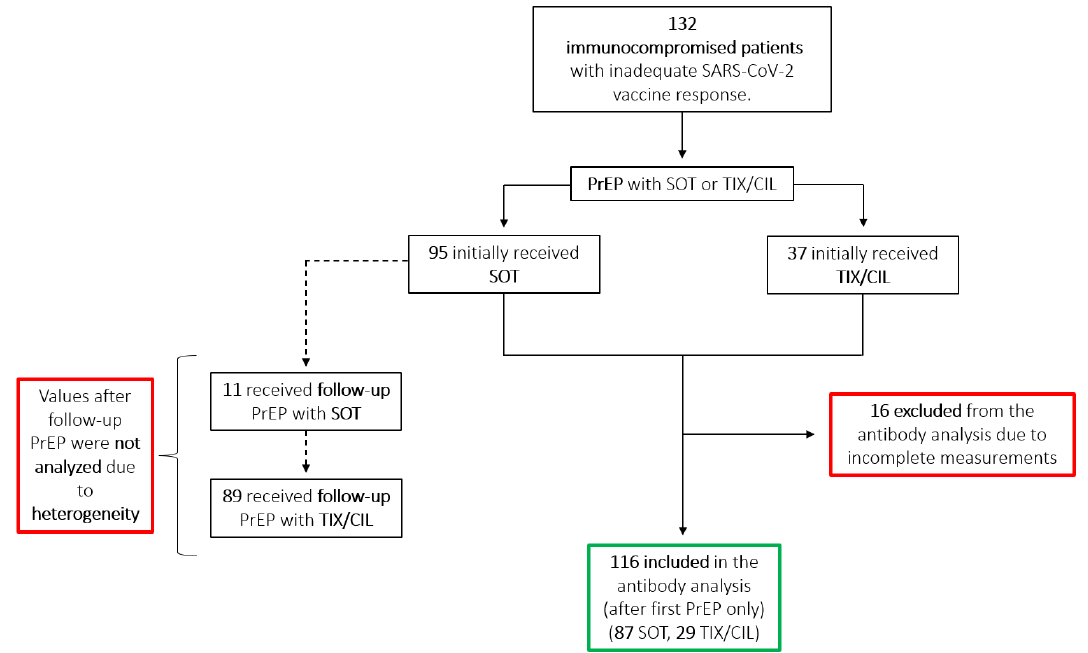
Figure 1. Flowchart showing the distribution of initial and follow-up PrEP among SOT and TIX/CIL. Antibody values resulting from follow-up PrEP were not analyzed due to the heterogeneity of mAb sequence and follow-up timing. The green border highlights included measurements; the red borders highlight excluded measurements. PrEP = Pre-exposure prophylaxis; SOT = sotrovimab; TIX/CIL = tixagevimab/cilgavimab; SARS-CoV-2 = severe acute respiratory syndrome coronavirus 2.